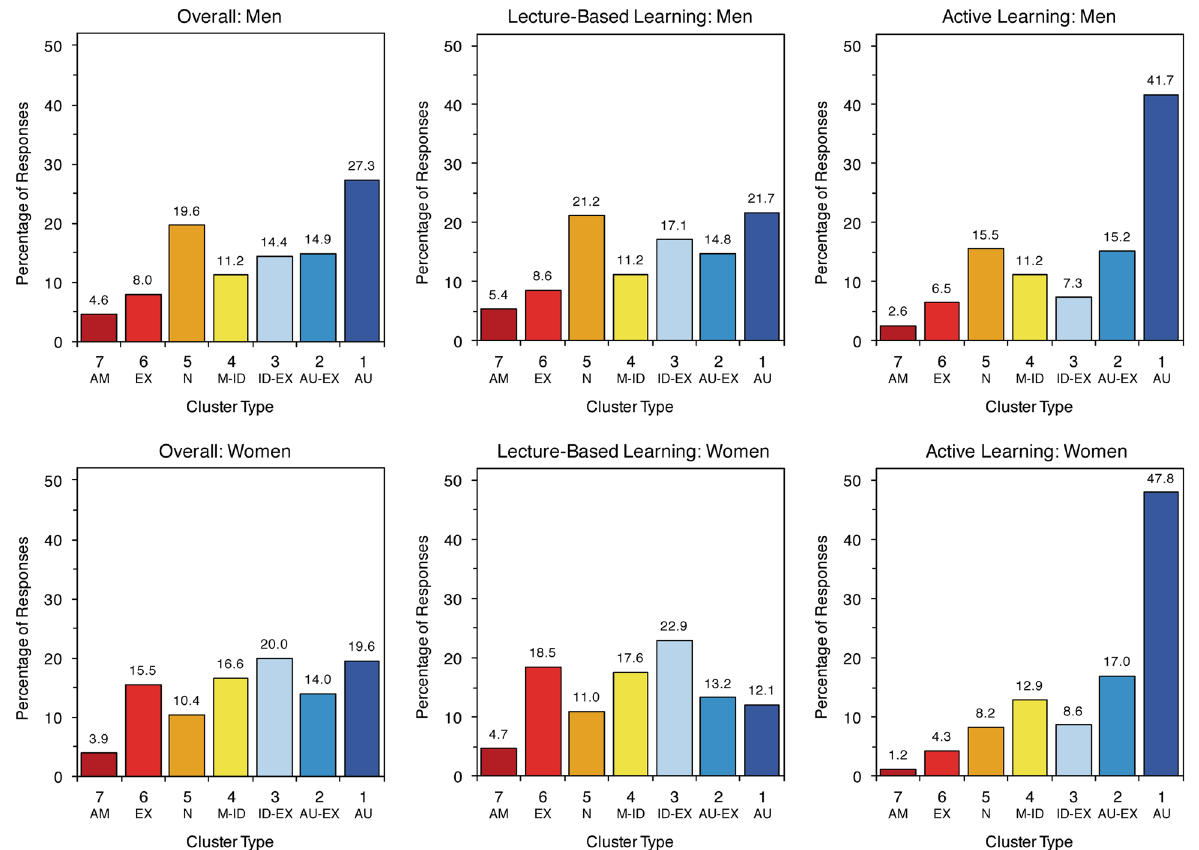
Fig. 3 Differences in cluster distributions for STEM courses, as a function of pedagogy and gender. Clusters are arranged from lowest SDI (left) to highest SDI